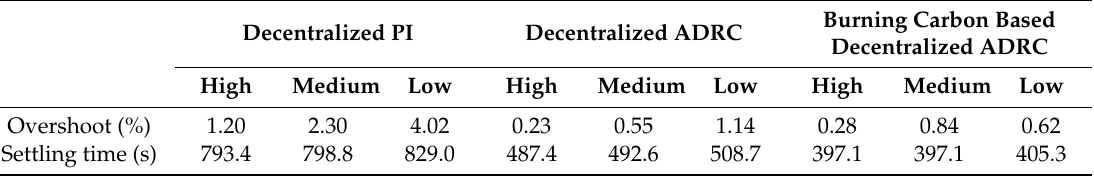
Table 2. Transient response criteria of throttle steam pressure for the supercritical CFB unit at typical conditions (load decrease).